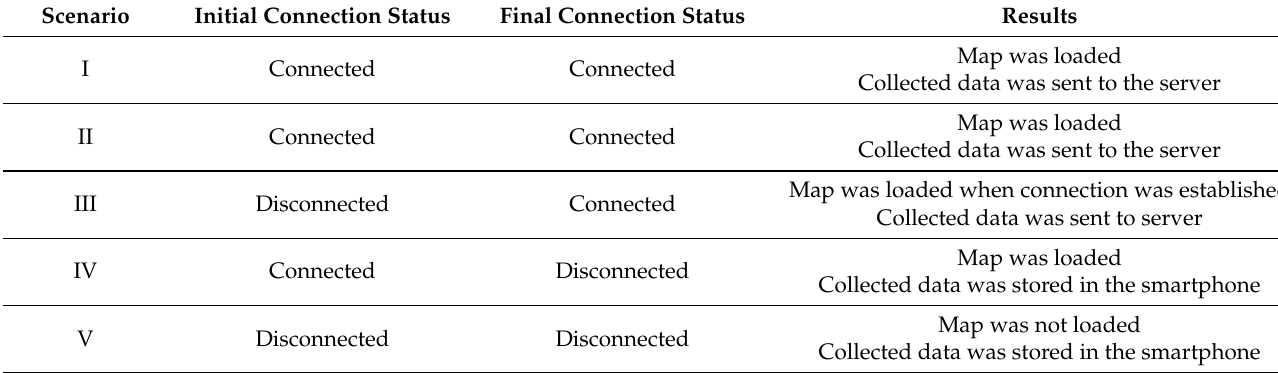
Table 2. Impact of connectivity failures.